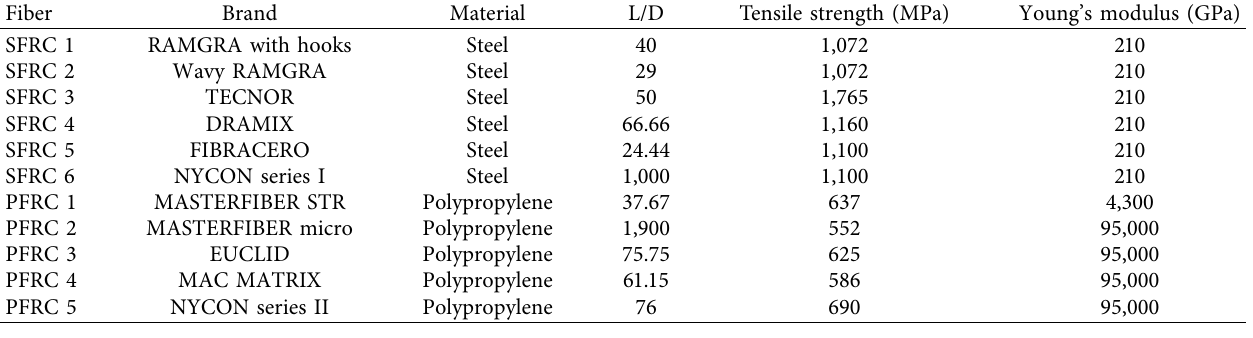
Table 1: Properties of the reinforcing